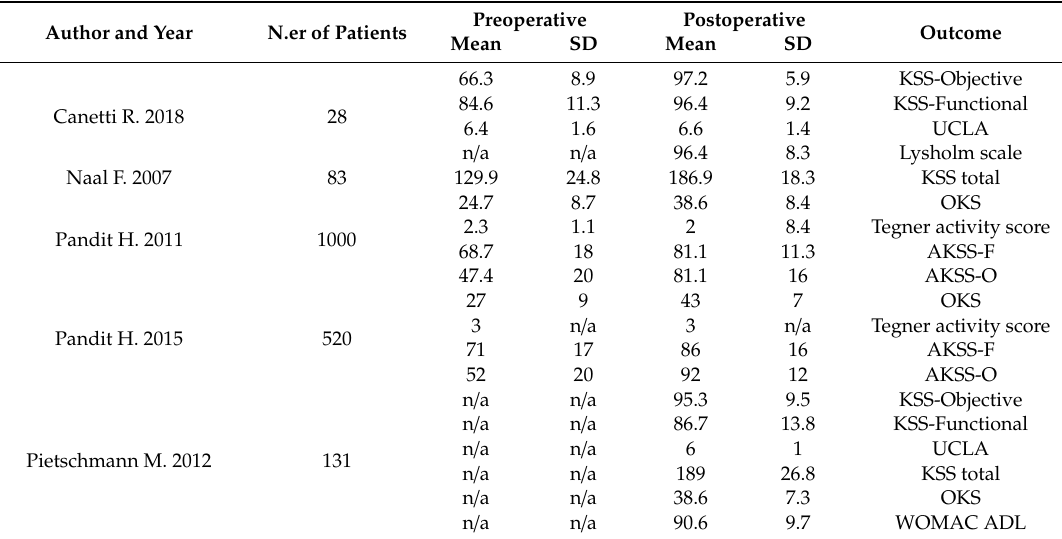
Table 2. Functional outcomes of included studies.